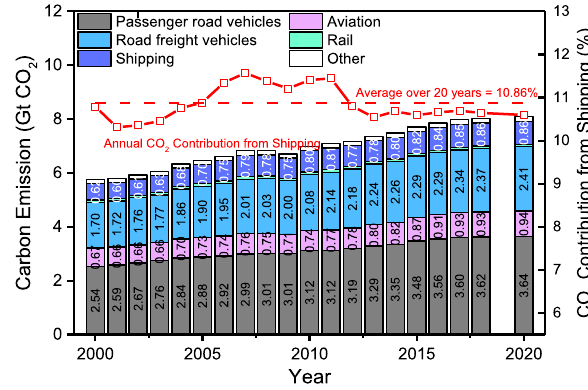
Fig. 1 Carbon emissions from various means of